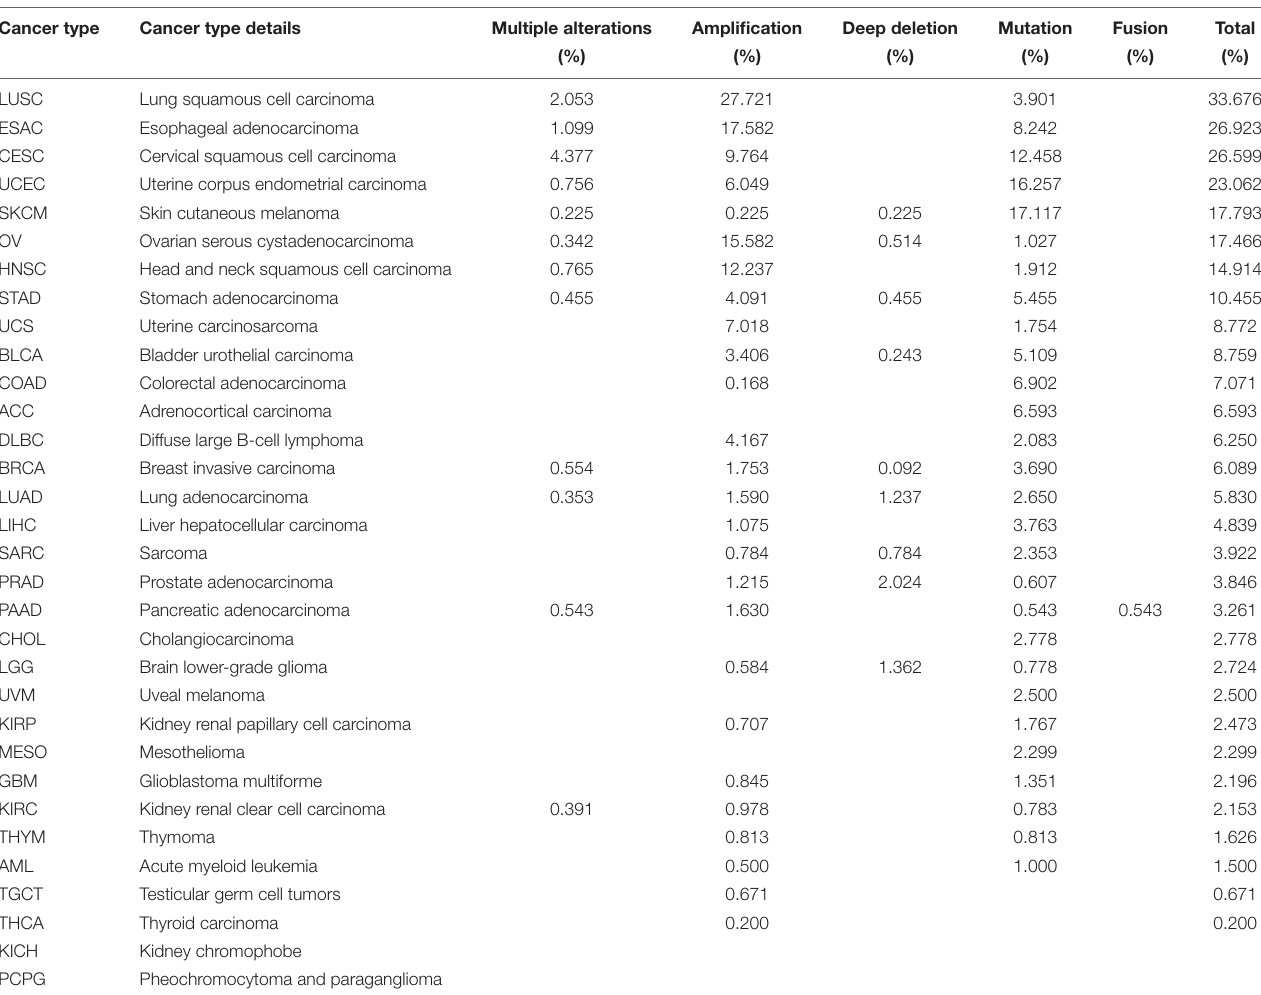
TABLE 1 | Alteration frequency of MUC4 across different cancer types in